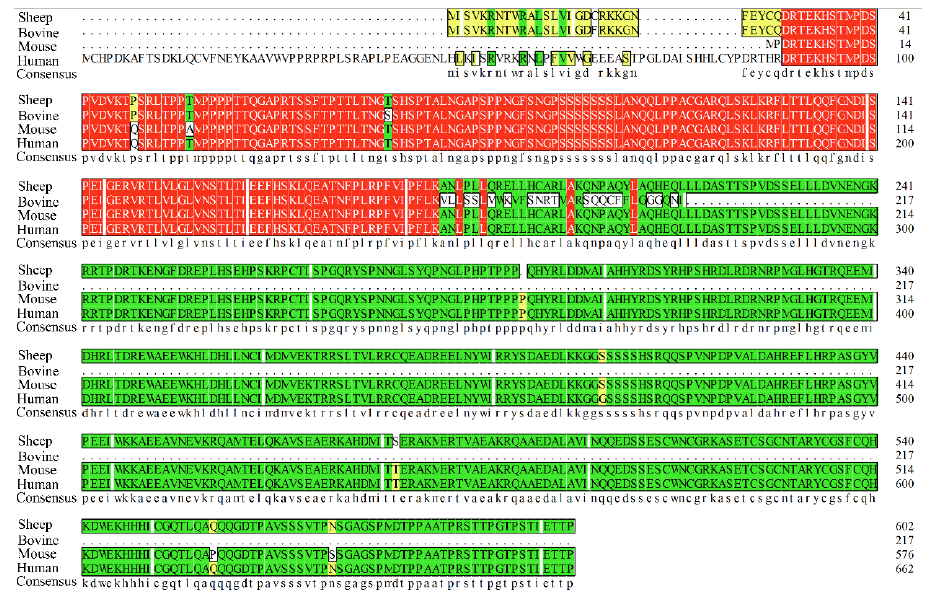
Figure 3. Comparison of the bovine, mouse, and human RUNX1T1 amino acid sequences. The RUNX1T1 amino acid sequence (Accession No.: MH063277) was aligned to those of bovine (Accession No.: NP_001092855), murine (Accession No.: EDL05616), and human (Accession No.: NP_001185608.1) by DNAMAN. The same amino acid residues in four, three and two species are highlighted in red, green, yellow respectively, while the amino acid residues present in only one species are highlighted in white. The apostrophes indicates that these amino acid sequences are absent.